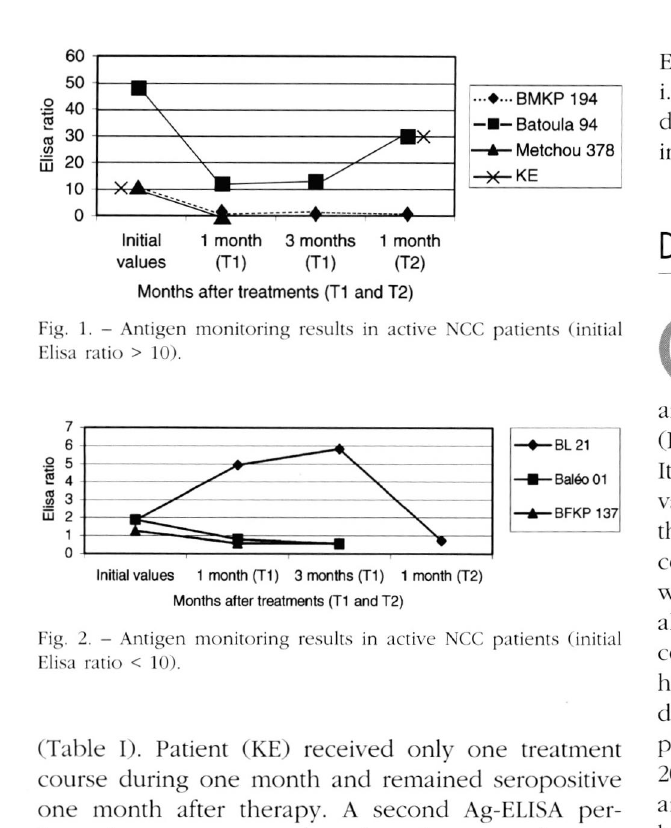
Fig. 1. - Antigen monitoring results in active NCC patients (initial Flisa ratio > 10).